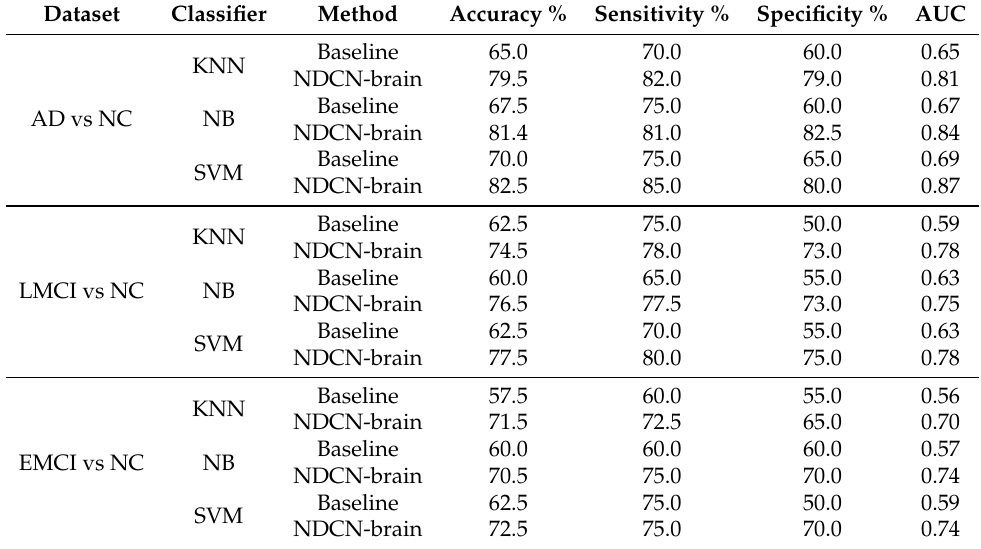
Table 7. Auxiliary diagnosis for cognitive impairment.